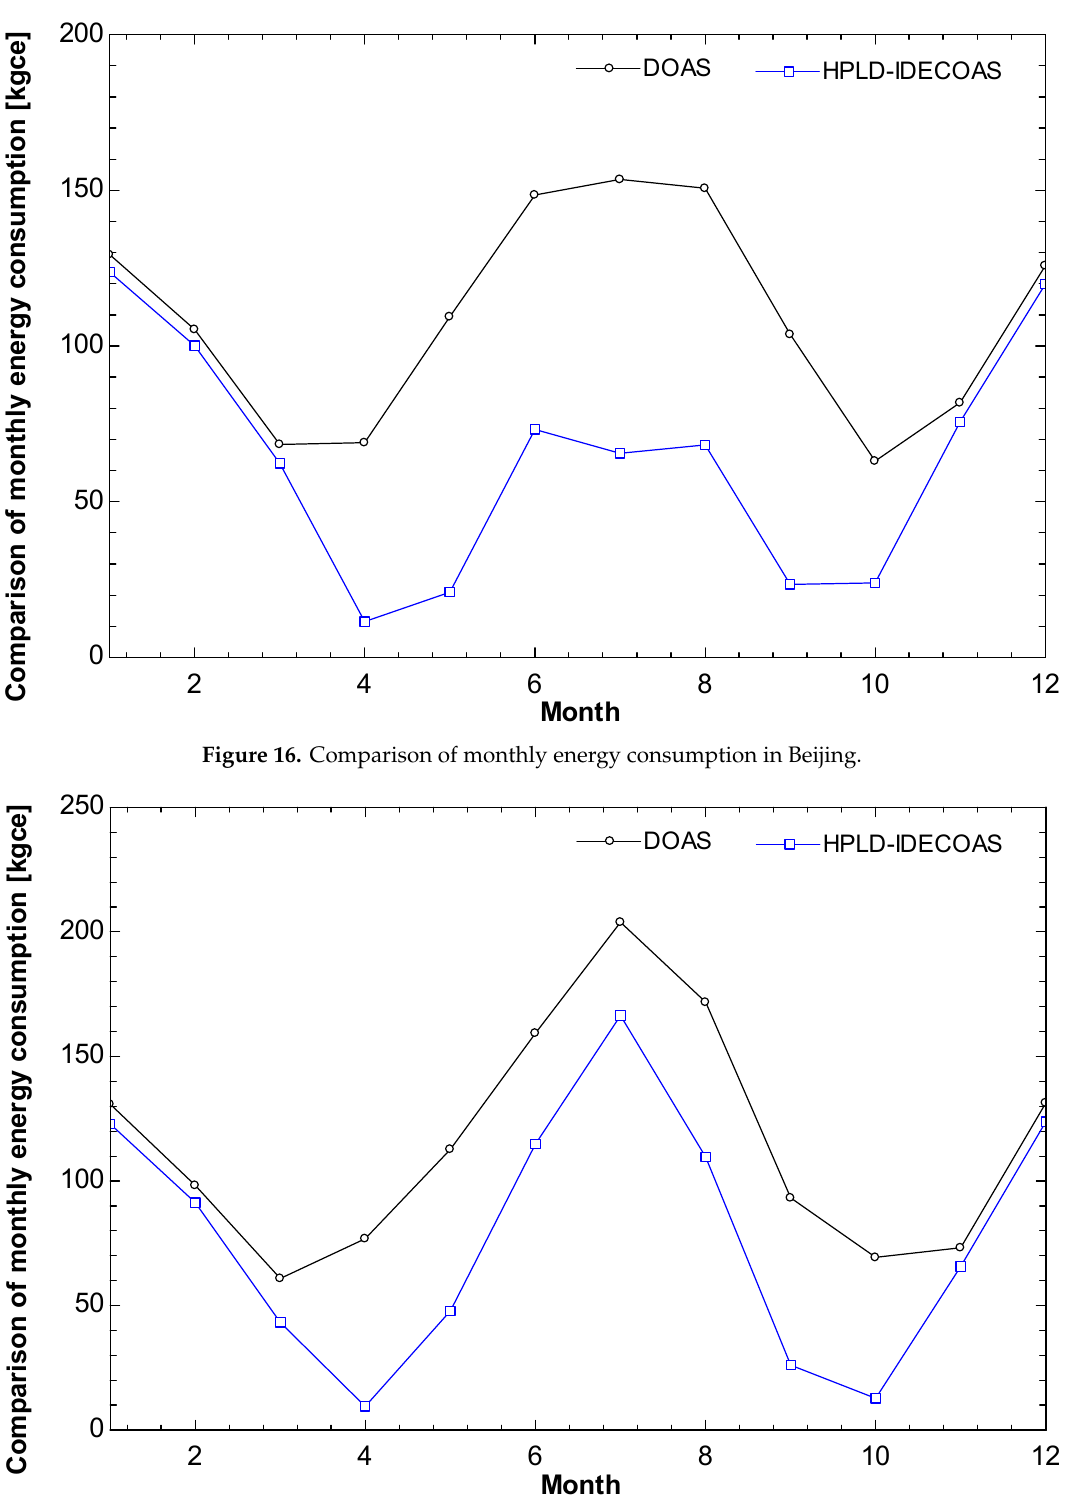
Figure 15. Comparison of monthly energy consumption in Kunming.